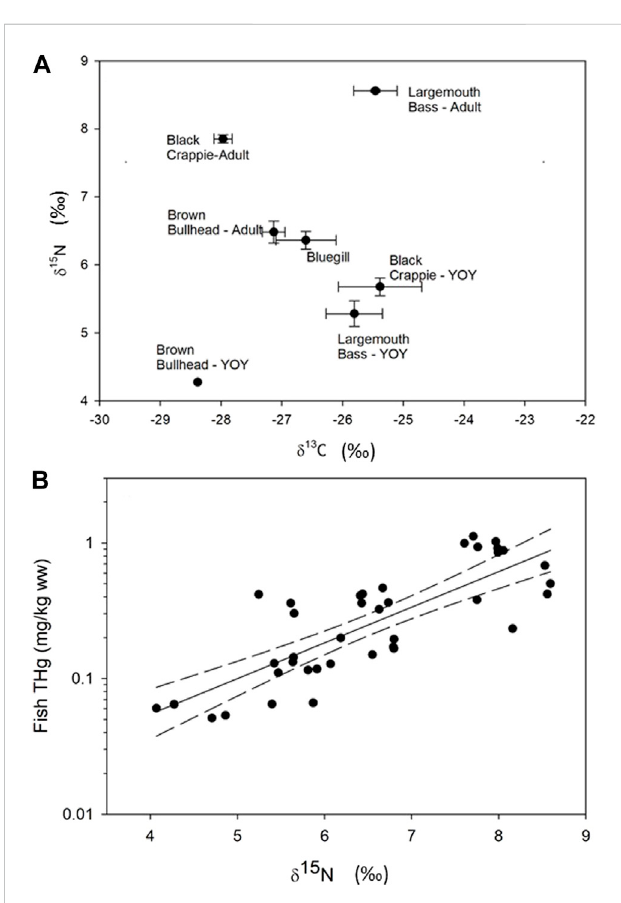
FIGURE 3 (A) shows the mean with standard error δ 15 N versus δ 13 C isotopic compositions in fi sh sampled in Cottage Grove Reservoir. (B) shows the relationship between tropic position (represented as δ 15 N) versus THg concentrations ( R 2 = 0.64, p < 0.0001; error bands represent 95% con fi dence